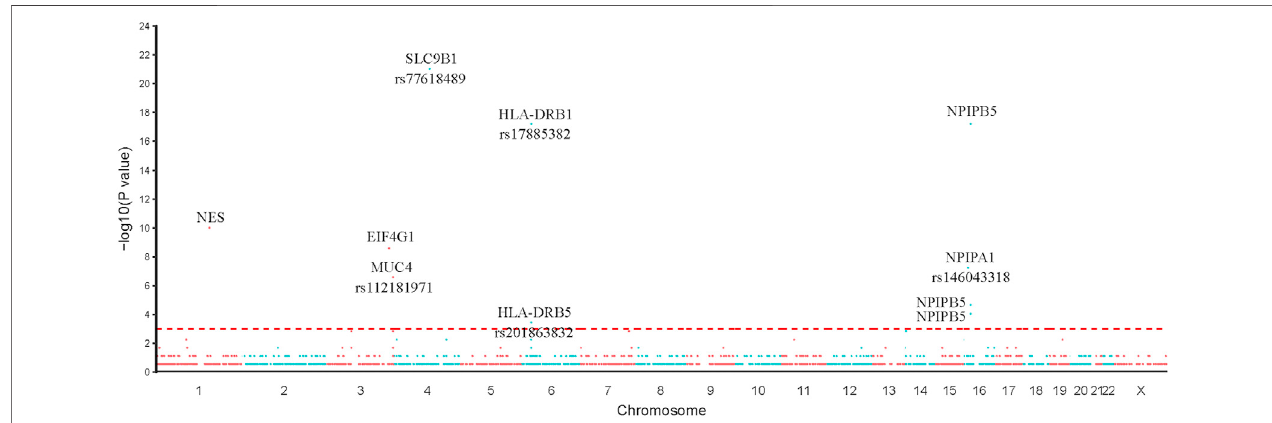
FIGURE 3 | Single SNP allele frequency and genotype frequency p -values were obtained using the fi sher exact test. X-axis represents the position of each snp (represented in circles) on human chromosome, Y-axis is the – log p -value of Fisher Exact test. Top 10 variants in our study were represented in the fi gure.